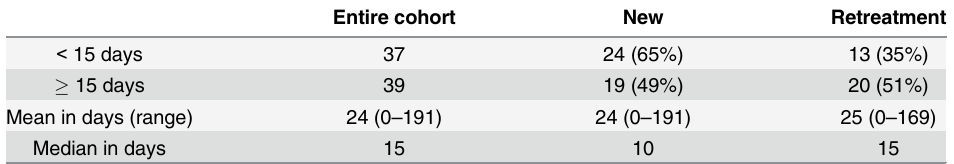
Table 2. Duration for first care seeking.